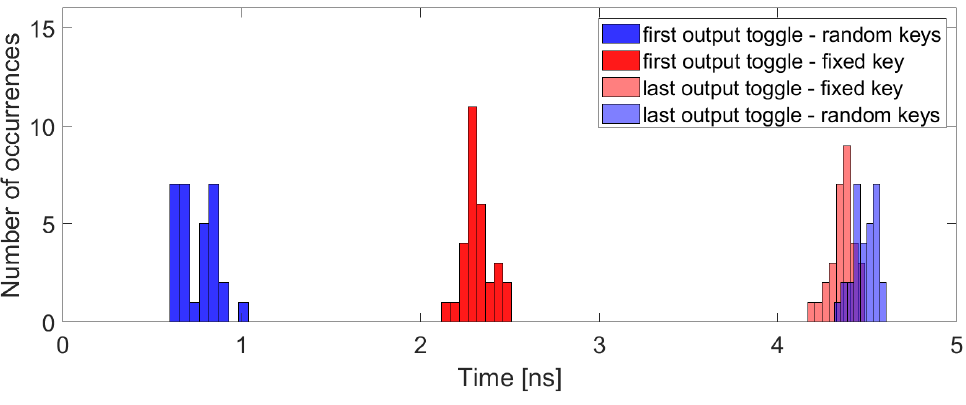
Figure 5: Timeline showing the distribution of first and last output toggles when simulating the unrolled PRINCE netlist for random plaintext transitions and either a fixed key (red) or random key transitions